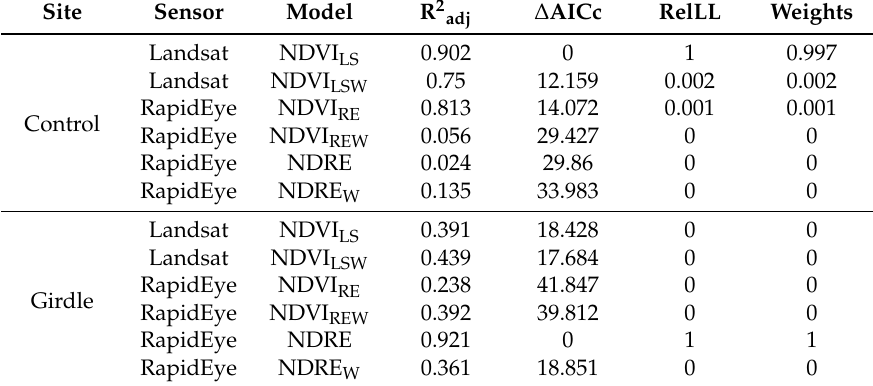
Table 2. Model performance statistics for only year 2009 of the experiment. See Table 1 for a description of model names. R 2 adj is the adjusted R 2 , ∆ AICc is the difference in model AICc (Akaike information criterion) relative to the lowest scoring model, RelLL is the relative log likelihood, or how likely it is that each model is actually the best, and Weights is a list of the AICc weights for each model. Site Sensor Model R 2 adj ∆ AICc RelLL